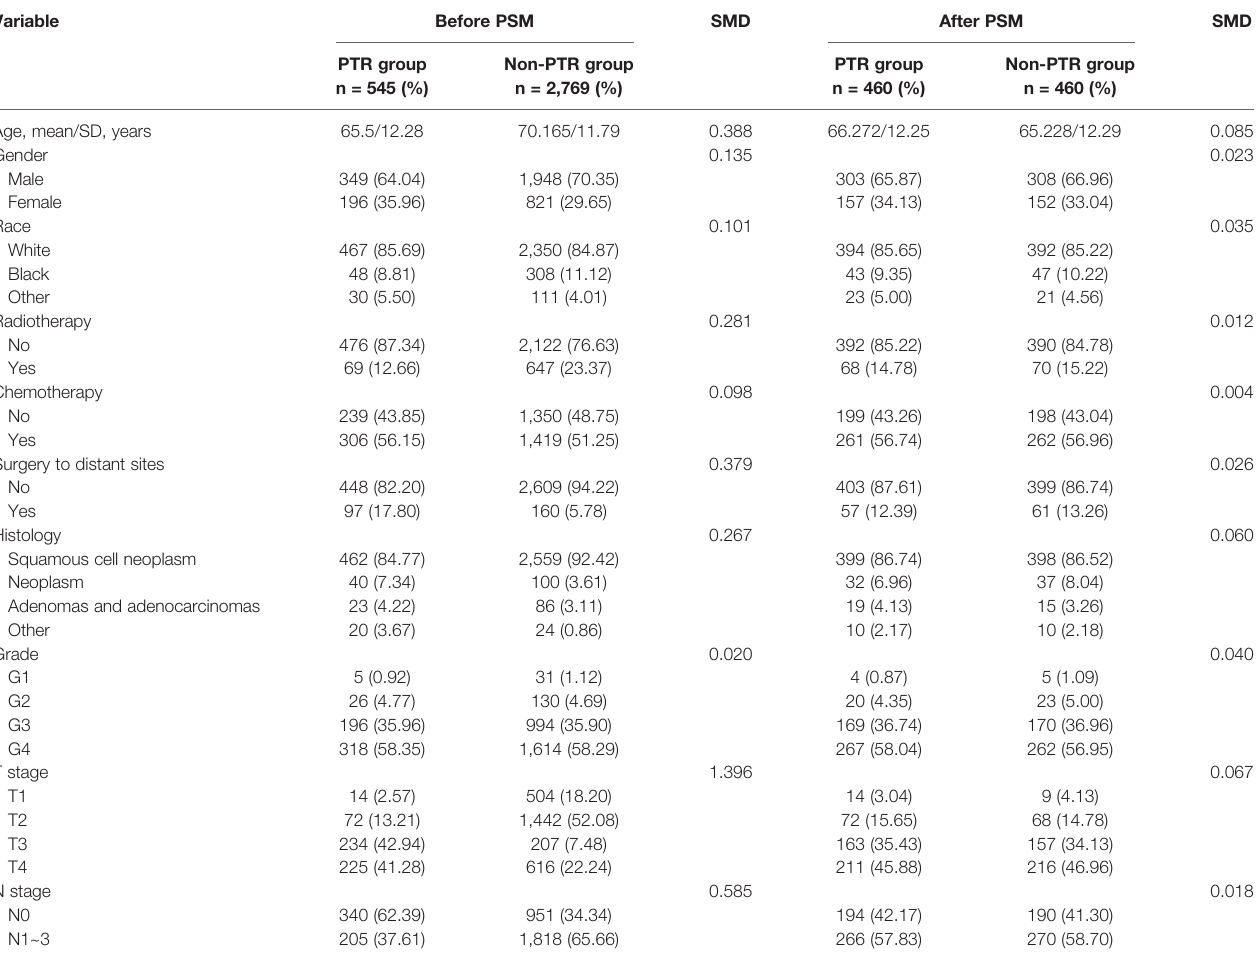
TABLE 1 | Baseline characteristics of the study population.